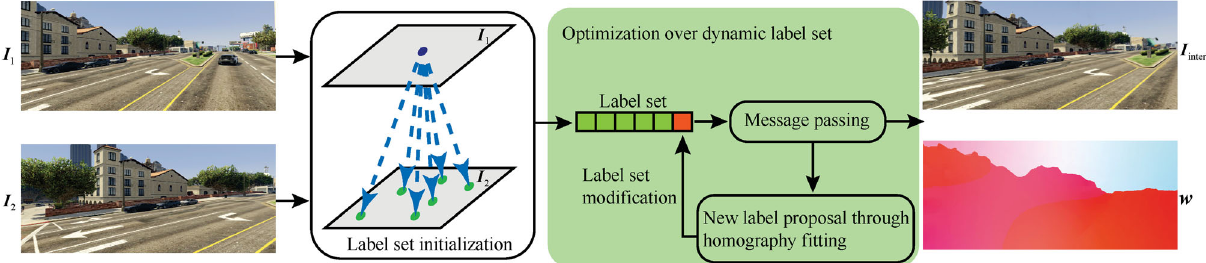
Fig. 1 Pipeline of our approach. Label set initialization composes the label sets using N nearest neighbors in feature space. In addition to iterative optimizing the objective function, the optimization phase marks the worst candidate in each label set by cost and replaces it by a new label proposal in each